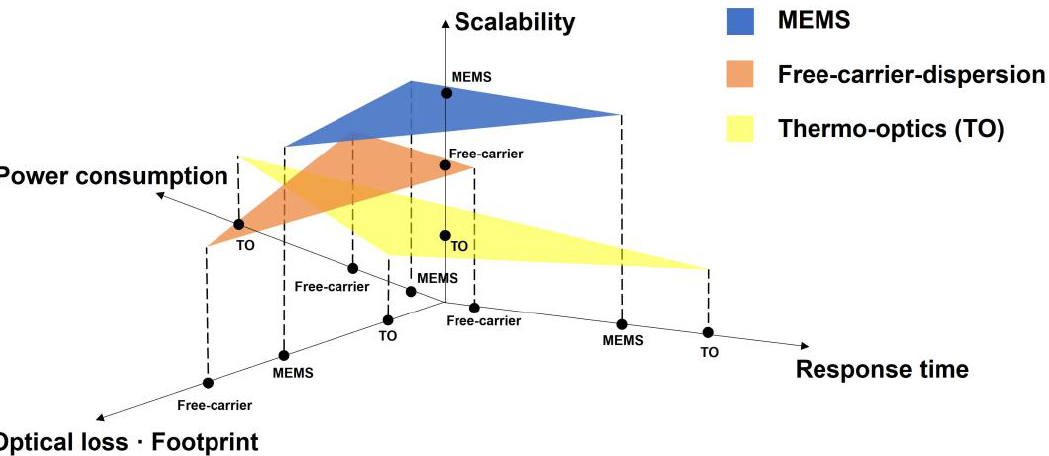
Figure 1. Semi-quantitative comparison between available methods for silicon photonic phase shift- ers.